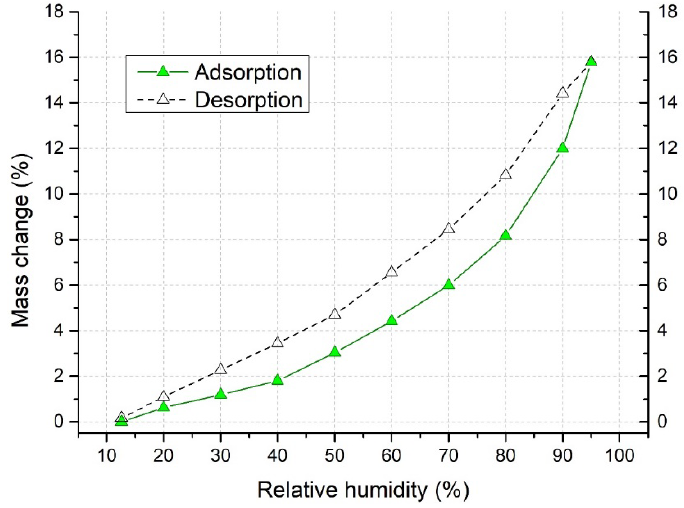
Figure 3. Adsorption and desorption isotherms of Avicel PH101 analyzed by Aquadyne DVS.